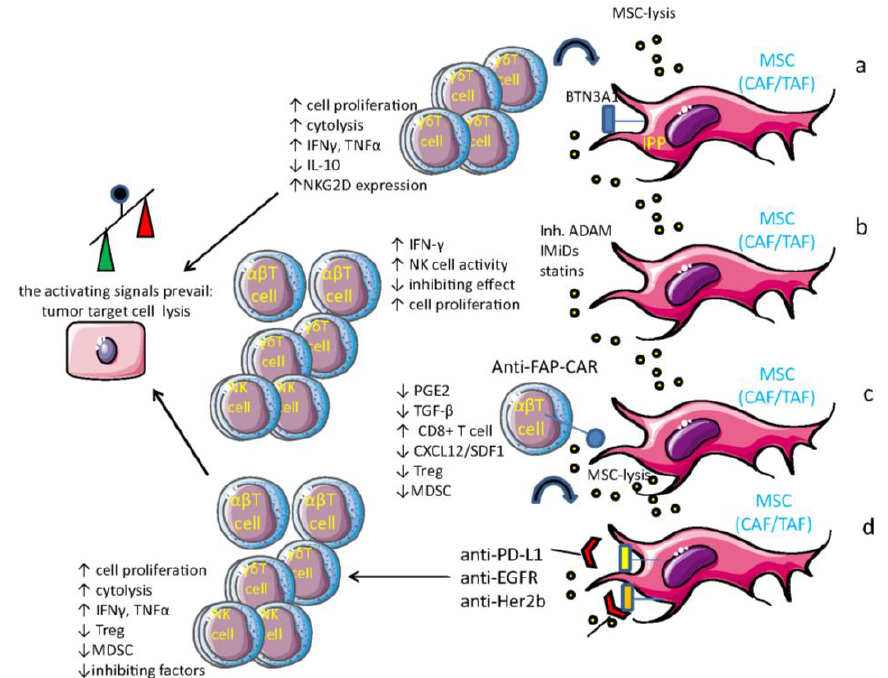
Figure 4. MSC as a target of tumor therapy. Several means can be used to relieve the MSC-mediated inhibition of anti-tumor immune response: ( a ) triggering Vδ2Vγ9 γδ T cells with aminobisphosphonates (N-BPs) such as zoledronic acid and accumulation in MSC of isopentenyl-pyrophosphate (IPP), which is presented by butyrophilin 3A1. This leads to (i) γδ T cell expansion; (ii) MSC elimination; and (iii) enhancement of anti-tumor cytolysis; ( b ) administration of ADAM inhibitors, immunomodulatory drugs (IMiDs), or statin, which impairs MSC’s assistance to tumor cells and triggers, at least for IMiDs, an immune reaction (ADAM inhibitors impair the shedding of NKG2D-L, increasing the NK cell-mediated recognition of target cells); ( c ) using T cells armed with chimeric anti-fibroblast activation protein (FAP)-antigen receptor (CAR) to eliminate MSC; ( d ) an analogous effect can be obtained with anti-EGFR and anti-Her2b humanized antibodies, which can activate antibody-dependent cytotoxicity (ADCC) and impair EGF-mediated pro-survival and proliferation effects. Overall, these different approaches can inhibit the establishment of a downregulating tumor microenvironment, increasing the immune reaction to tumor cells.